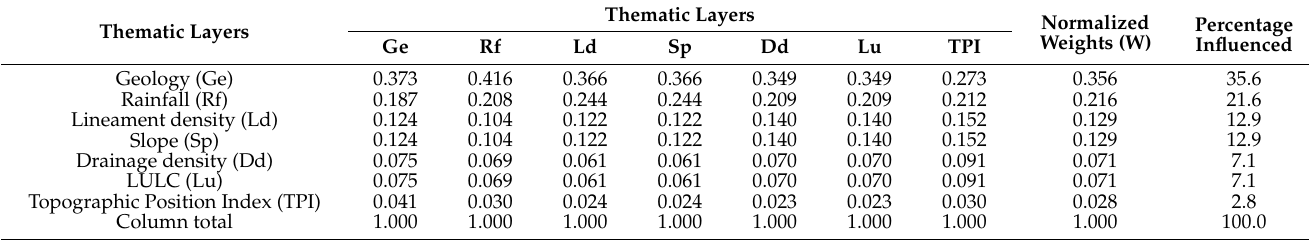
Table 4. Normalized pairwise comparison matrix (PCM) for the AHP process in the Sangaw